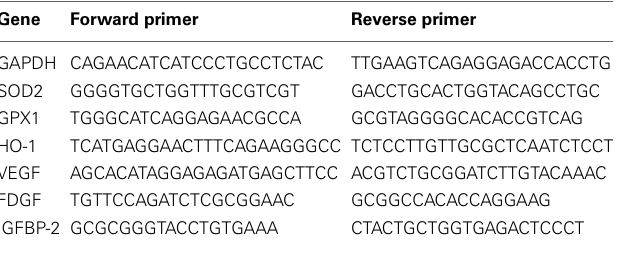
Table 1 | The sequences for the primers of RT-PCR. Gene Forward primer Reverse primer endo